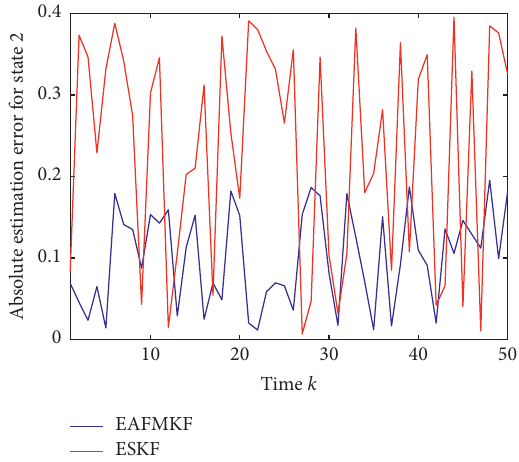
Figure 6: Estimation error curve for state 2.